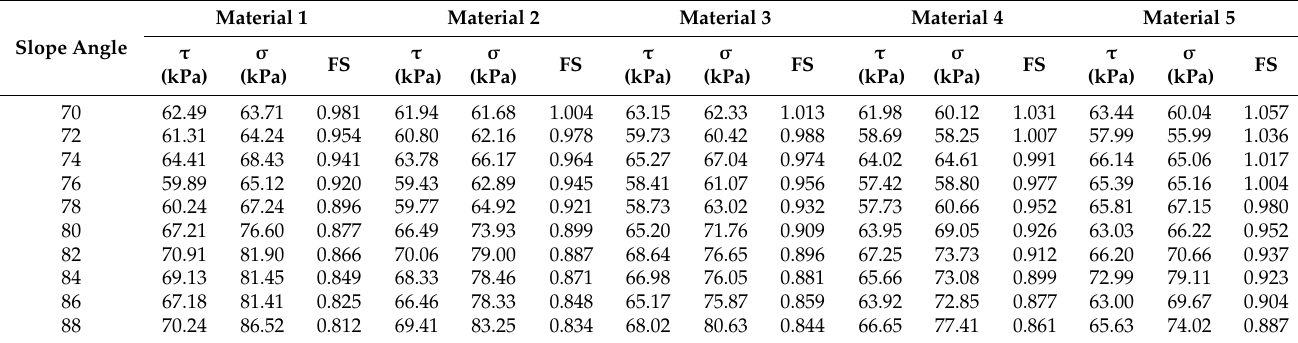
Table 5. τ and σ in the case of an unsaturated seismic analysis—Materials 1 to 5.